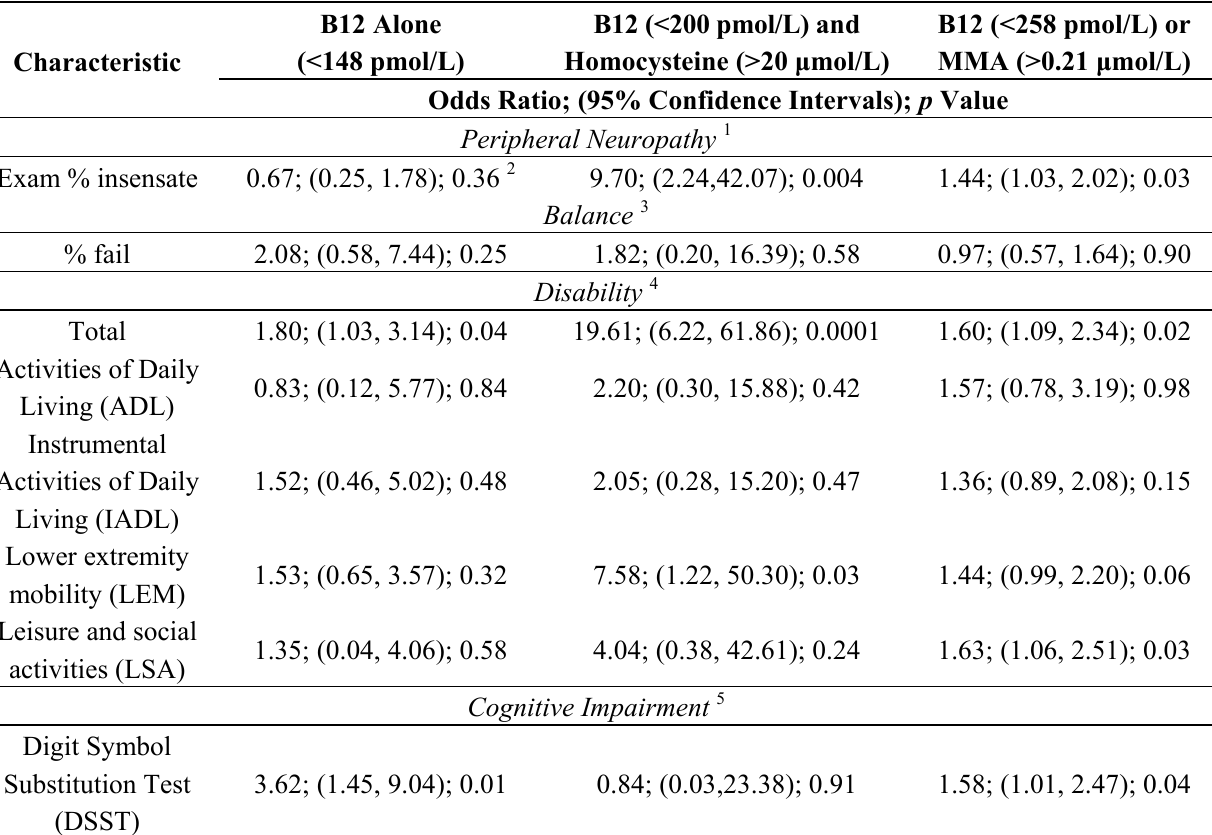
Table 2. Odds of physical impairments and reported disabilities in 3015 persons 60 years and older from NHANES 1999–2000 and 2001–2002 as a function of